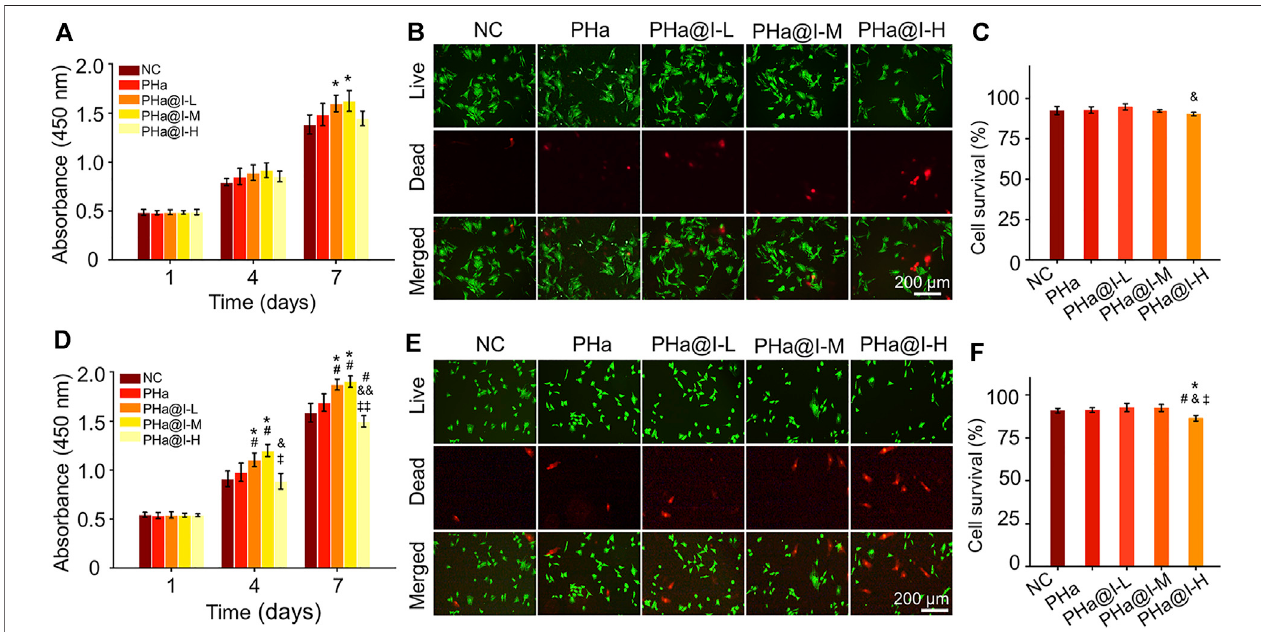
FIGURE2| Biocompatibilityof3Dcellculturesystemcomposedoficariin-loadedhydrogelsonbonemarrowmesenchymalstemcells(BMSCs)andchondrocytes. (A) BMSC proliferation at days 1, 4, and 7. (B) Calcein AM/PI staining of BMSCs at day 3. The green signal represents live cells, whereas the red signal represents dead cells. (C) Quantitative analysis of the survival rates of BMSCs according to Calcein AM/PI staining. (D) Chondrocyte proliferation at days 1, 4 and 7. (E) Calcein AM/PI staining of chondrocytes at day 3. The green signal represents live cells, whereas the red signal represents dead cells. (F) Quantitative analysis of the survival rates of chondrocytes according to Calcein AM/PI staining (* p < .05 compared with the NC group; # p < .05 compared with the PHa Group; & p < .05 and && p < .01 compared with the PHa@I-L Group; ‡ p < .05 and ‡‡ p < .01 compared with the PHa@I-M Group, n =